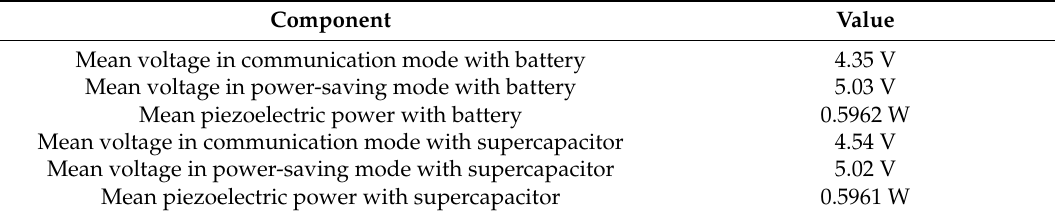
Figure 9. Low-cost bus voltage over 900 s using the ( a ) battery and ( b ) 2.5 F supercapacitor. Table 5. Summary of the minimum-power piezoelectric harvester